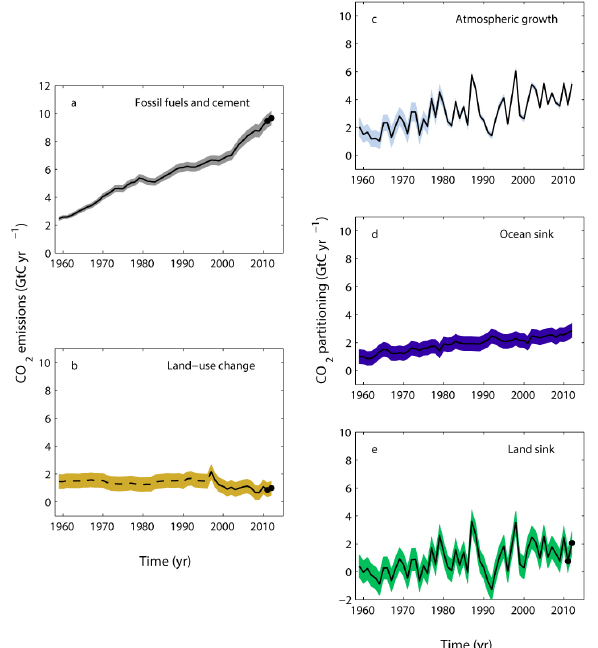
Figure 4. CO 2 emissions from fossil-fuel combustion and cement production for (a) the globe, including an uncertainty of ± 5% (grey shading), the emissions extrapolated using BP energy statis- tics (black dots) and the emissions projection for year 2012 based on GDP projection (red dot), (b) global emissions by fuel type, in- cluding coal (red), oil (black), gas (blue), and cement (purple), and excluding gas flaring which is small (0.7% in 2011), (c) territorial (full line) and consumption (dashed line) emissions for the countries listed in the Annex B of the Kyoto Protocol (blue lines; mostly ad- vanced economies with emissions limitations) versus non-Annex B countries (red lines); also shown are the emissions transfer from non-Annex B to Annex B countries (black line), (d) territorial CO 2 emissions for the top three country emitters (USA – purple; China – red; India – green) and for the European Union (EU; blue for the 28 member states of the EU in 2012), and (e) per-capita emissions for the top three country emitters and the EU (all colours as in d ) and the world (black). In (b–e) , the dots show the data that were extrap- olated from BP energy statistics for 2011 and 2012. All time series are in GtCyr − 1 except the per-capita emissions (e) , which are in tonnes of carbon per person per year (tCperson − 1 yr − 1 ) . All terri- torial emissions are primarily from Boden et al. (2013) as detailed in the text; consumption-based emissions are updated from Peters et al.